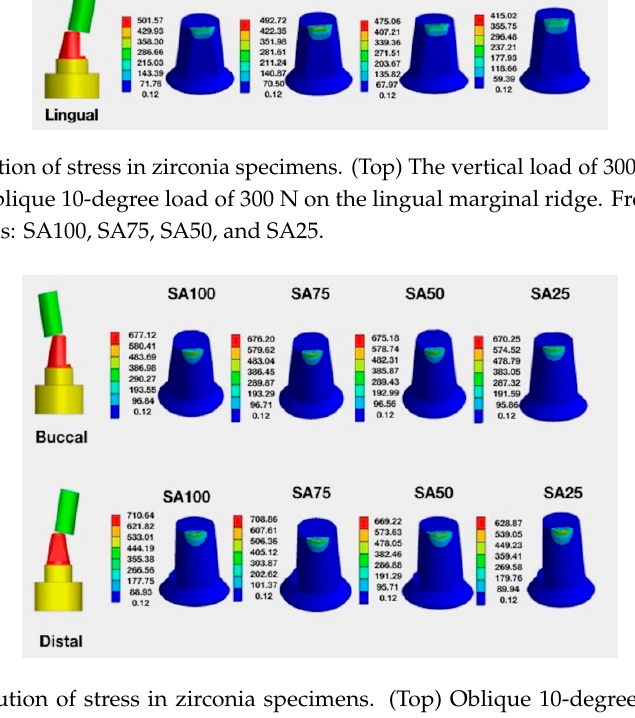
Figure 7. Distribution of stress in zirconia specimens. (Top) Oblique 10-degree load of 300 N on the buccal marginal ridge. (Bottom) Oblique 10-degree load of 300 N on the buccal marginal ridge. From the left to right are loading models: SA100, SA75, SA50, and SA25.